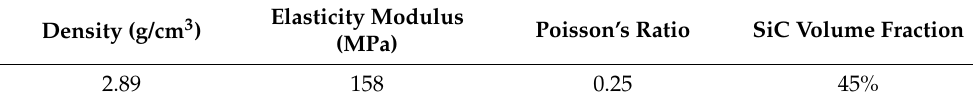
Table 2. SiCp/Al material properties.